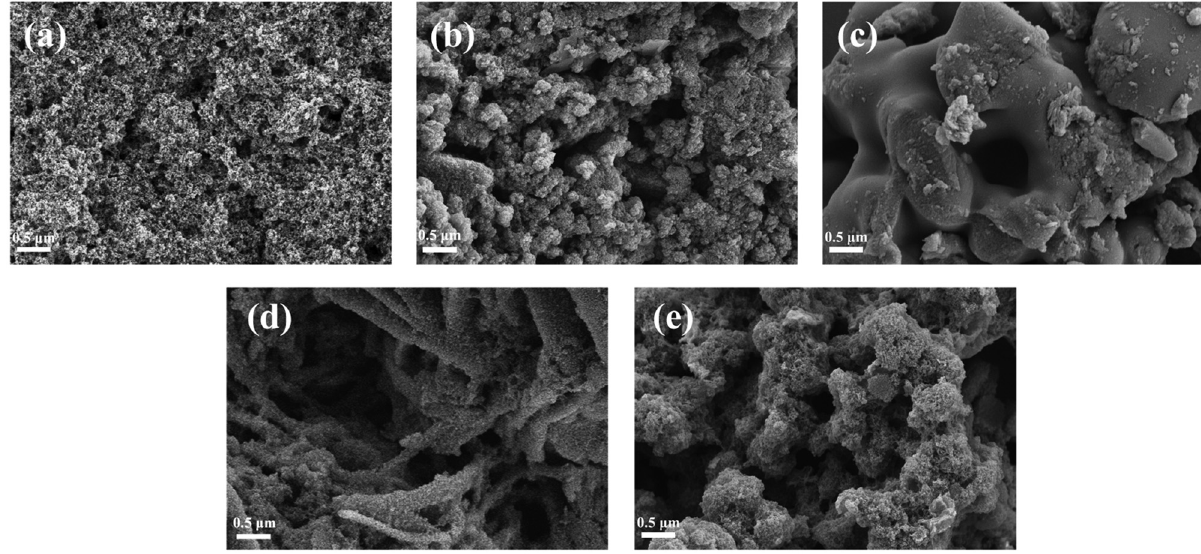
Figure 6: SEM images of HCPs prepared from veri fi ed precursors: ( a ) HCP - BEN, ( b ) HCP - BA, ( c ) HCP - ANI, ( d ) HCP - BPH, and ( e ) HCP -